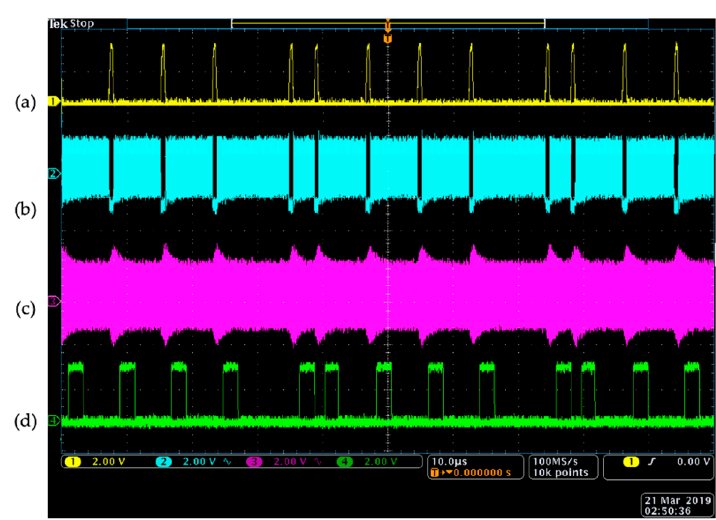
Figure 10. ( a ) The data encoded according to differential pulse position algorithm at the implantable unit, ( b ) the voltage of the secondary coil which drops to zero when the back-telemetry circuit sends a high-pulse of data, ( c ) the voltage of the primary coil which slightly increases when there is a change of impedance at the secondary coil, and ( d ) the demodulated data at the output of the RFID reader’s envelope detector. The time per division on the x-axis and the voltage per division on the y-axis for all four signals are 10 µs and 2 V, respectively.